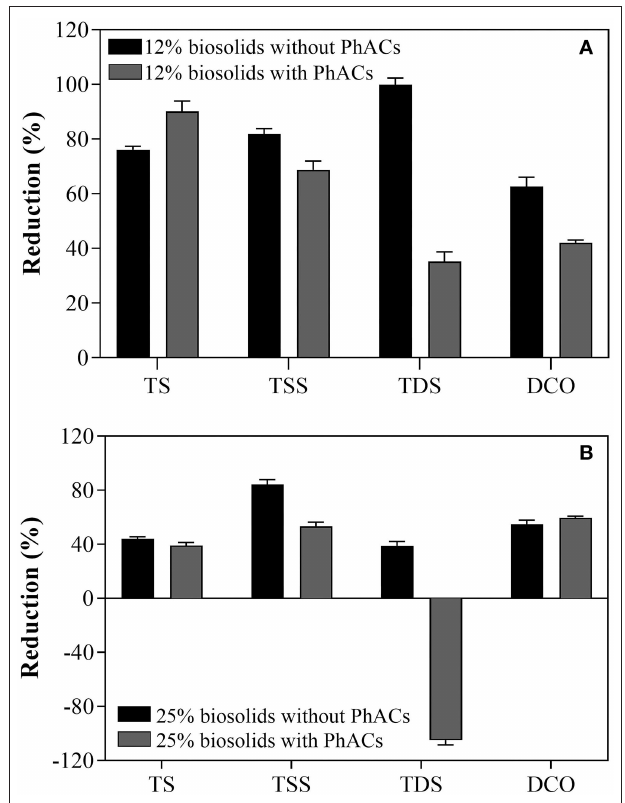
FIGURE 2 | Biosolids volume reduction after 35 days of treatment with T. hirsuta in 12% biosolid-based growth (A) and in 25% biosolid-based growth (B)